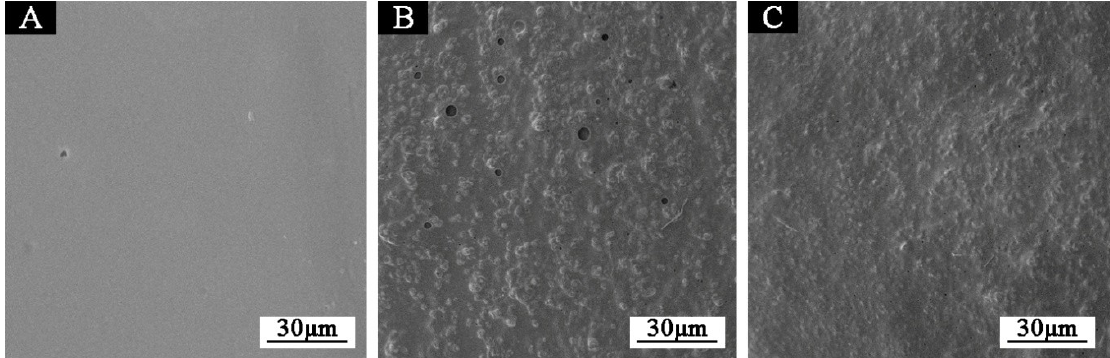
Figure 8. SEM of waterborne coatings with different contents of microcapsules: ( A ) 0; ( B ) 10.0% and ( C ) 12.0%.